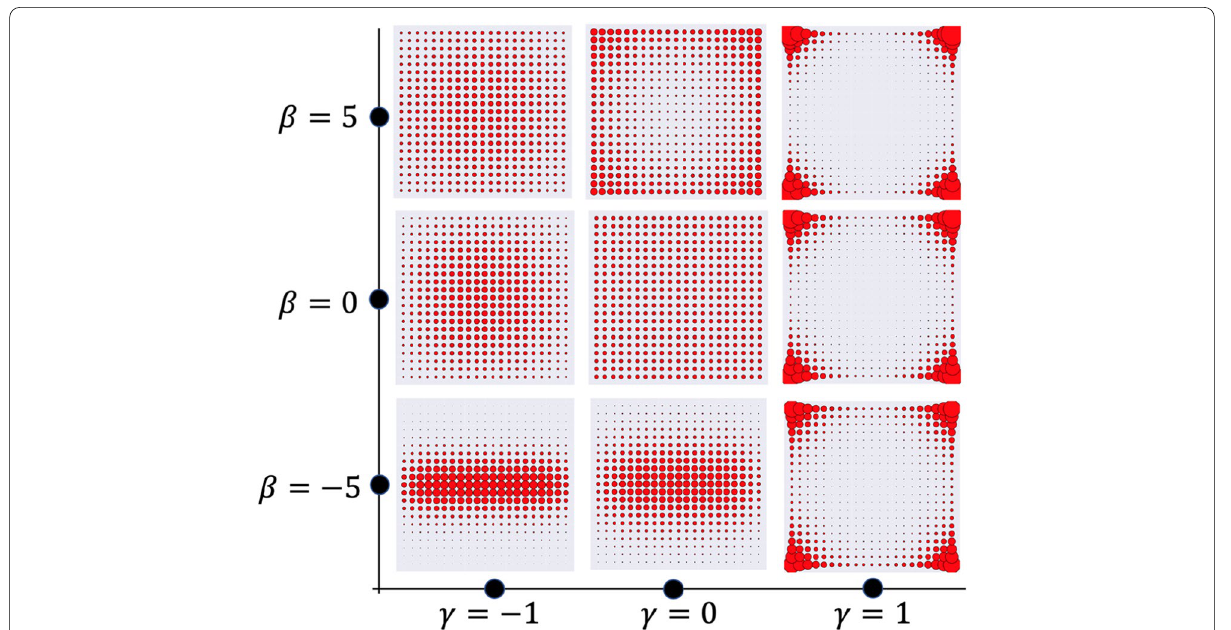
Fig. 10 The Limits of the Solution Space for Different Parameter Values of d β rs exp ( γ d rs